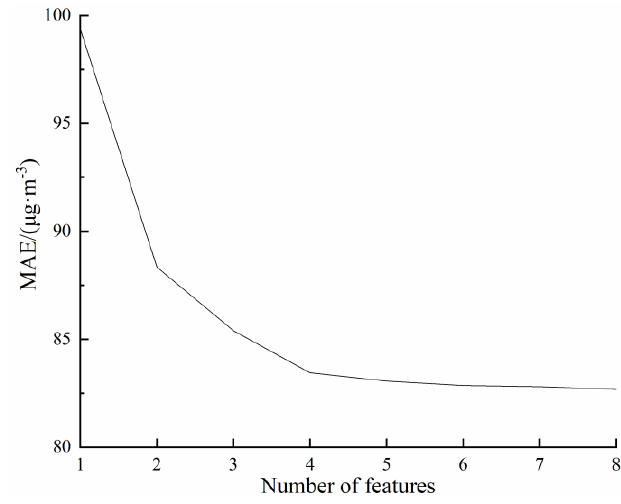
Figure 5. Average absolute error curve based on number of features.